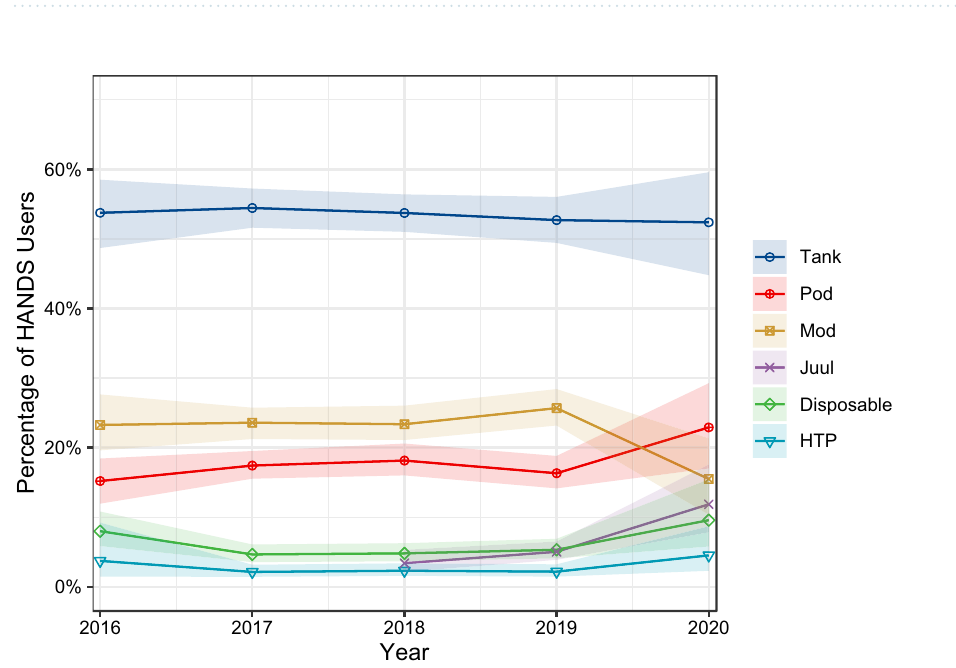
Table 1. Sample characteristics by type of device used ( n = 3786). The percentage who used each different device type are shown in brackets. People could report that they used multiple products. a Heated aerosolized nicotine delivery systems (HANDS) include e-cigarettes and heated tobacco products. b The denominator used to calculate percentages in this column was the number of HANDS users surveyed from July 2018—the month in which JUUL use began being recorded—to February 2020 ( n = 1760). c The denominator used to calculate percentages in this column was the number of HANDS users surveyed from December 2016—the month in which heated tobacco products (HTPs) use began being recorded—to February 2020 ( n = 3520).